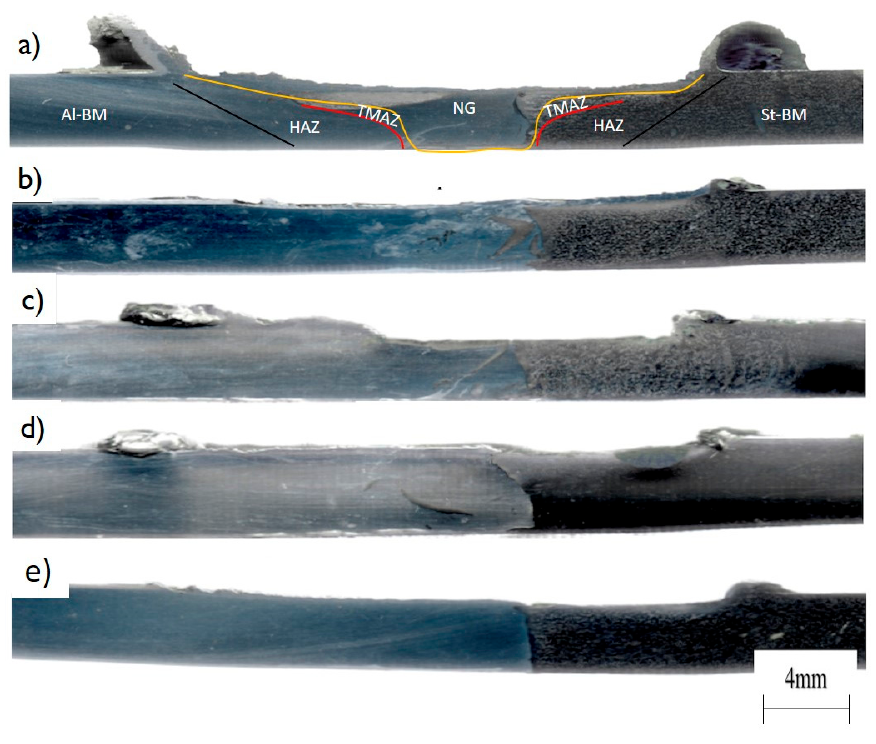
Figure 4. Optical macrographs of the transverse cross-sections of the FSWed aluminum alloy AA2024 and mild steel 1018 joints at different welding conditions: ( a ) 200 rpm and 50 mm/min; ( b ) 250 rpm and 50 mm/min; ( c ) 300 rpm and 50 mm/min; ( d ) 250 rpm and 25 mm/min; and ( e ) 250 rpm and 75 mm/min.